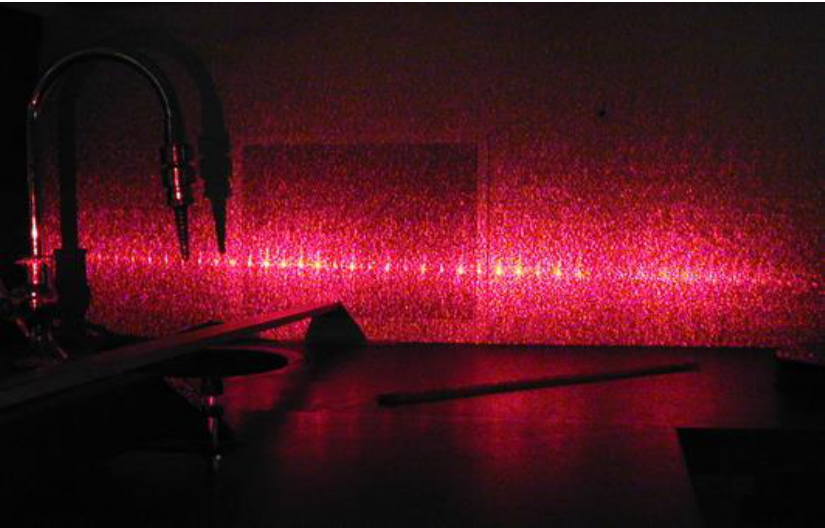
Figure 10. Diffraction from an imprinted saw-teeth film with a helium neon